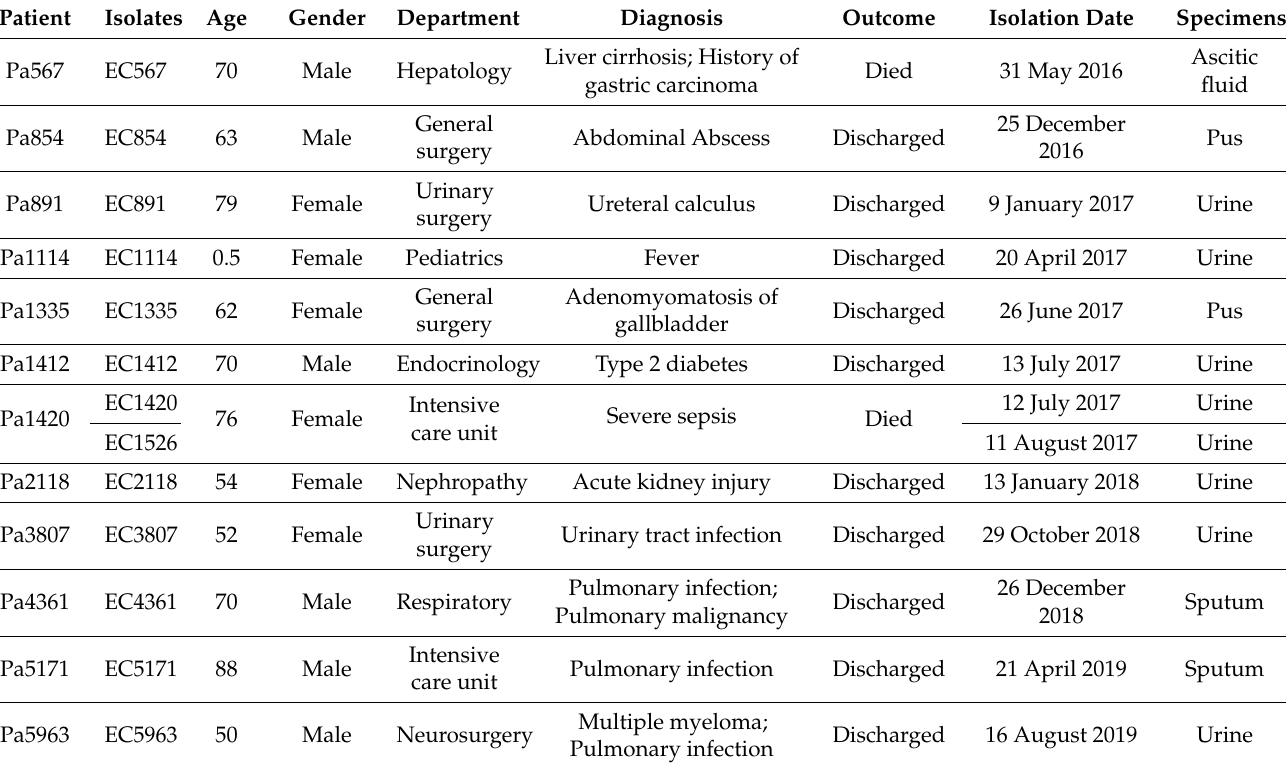
Table 1. Clinical data and outcomes of the 12 inpatients with mcr -carrying E. coli